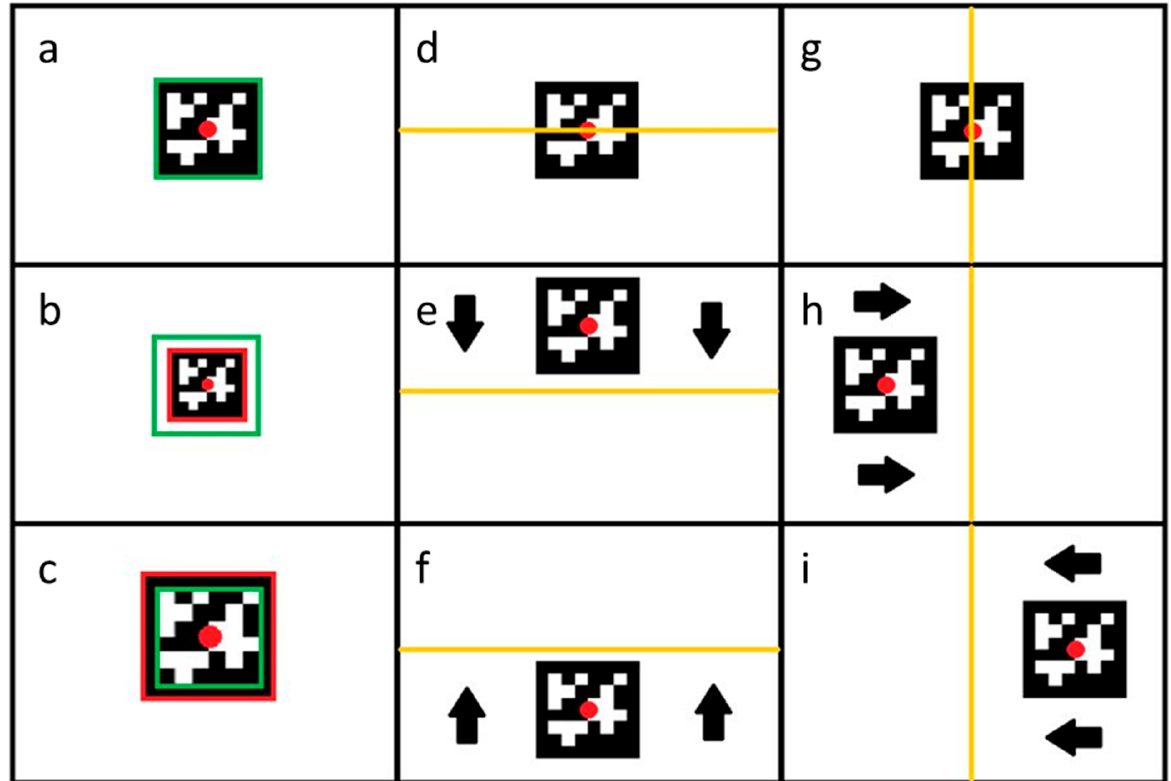
Figure 6. All conditions of the marker position. ( a ) desired distance—no action; ( b ) too far—move forward; ( c ) too close—move backward; ( d ) desired vertical position; ( e ) too low—move up; ( f ) too high—move down; ( g ) desired horizontal position; ( h ) too right—move left; ( i ) too left—move right.